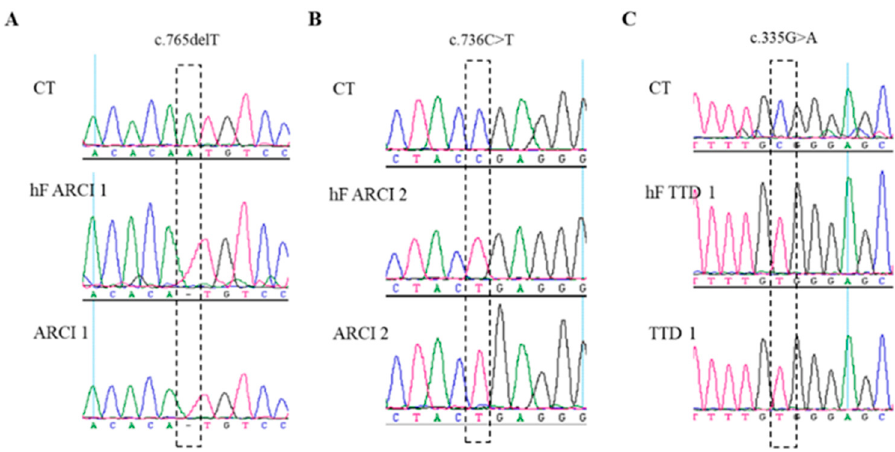
Figure 2. Generated patient-specific hiPSCs maintain the disease-causing variant. DNA was extracted from dermal fibroblasts of a healthy donor (CT), patient-derived dermal fibroblasts (hFs), and hiPSCs (ARCI1, ARCI2 and TTD1, respectively) and analyzed by Sanger sequencing. ( A ) ARCI 1 patient cells showing novel homozygous TGM1 (NM_000359.3) 1bp deletion c.765delT; ( B ) ARCI 2 patient cells with homozygous nonsense change c.736C>T in exon 5 of PNPLA1 (NM_001145717); ( C ) TTD1 patient cells showing the homozygous ERCC2 (NM_000400.4) exon 5 missense change c.335G>A. None of the variants were detected in unaffected control cells (CT).